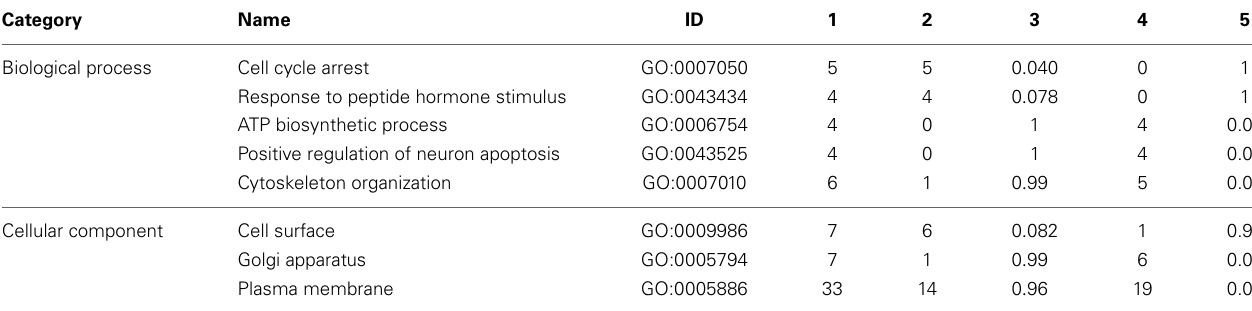
Table 2 | Gene ontology analysis of uninfested resistant and susceptible dark-eyed pupae (S88-/G4-). Category